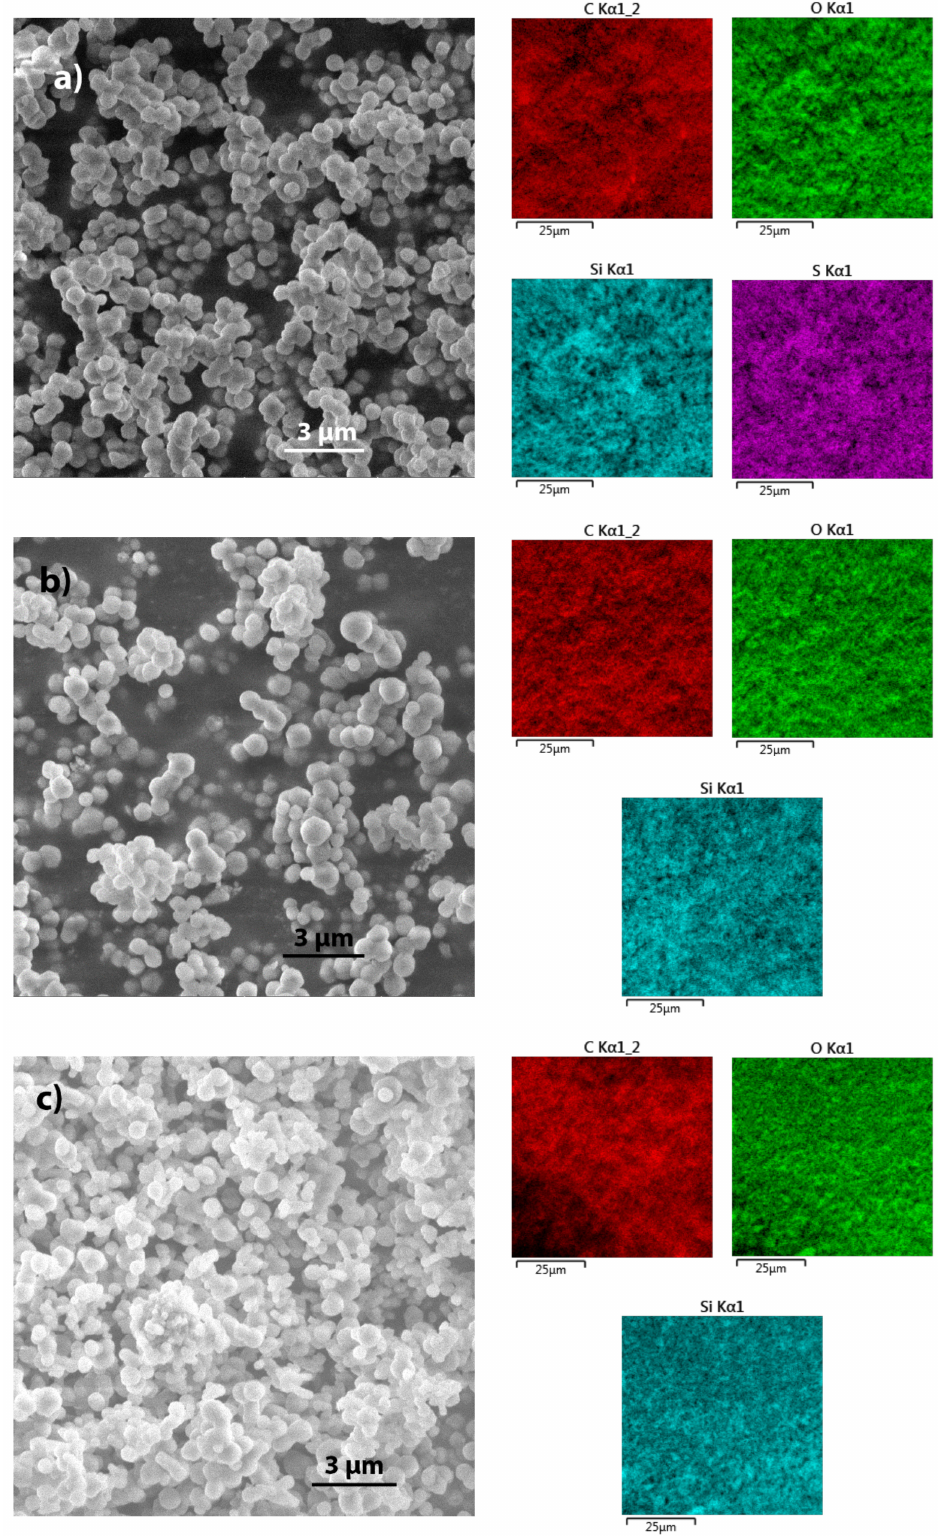
Figure 5. SEM data and surface mapping: ( a ) SH-0.33-0.13; ( b ) Me-0.33-0.09; ( c )